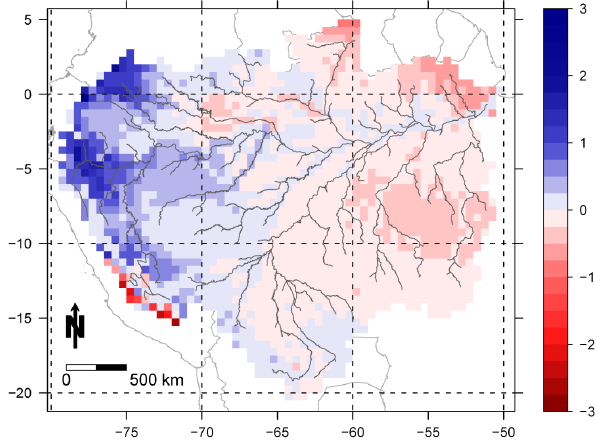
Fig. 7. Lengthening (blue) and shortening (red) of duration of inun- Figure 7. Lengthening (blue) and shortening (red) of duration of inundation in months 849 dation in months (mean over 24 model realisations) between future and reference (mean over 24 model realizations) between future and reference period. 850 851